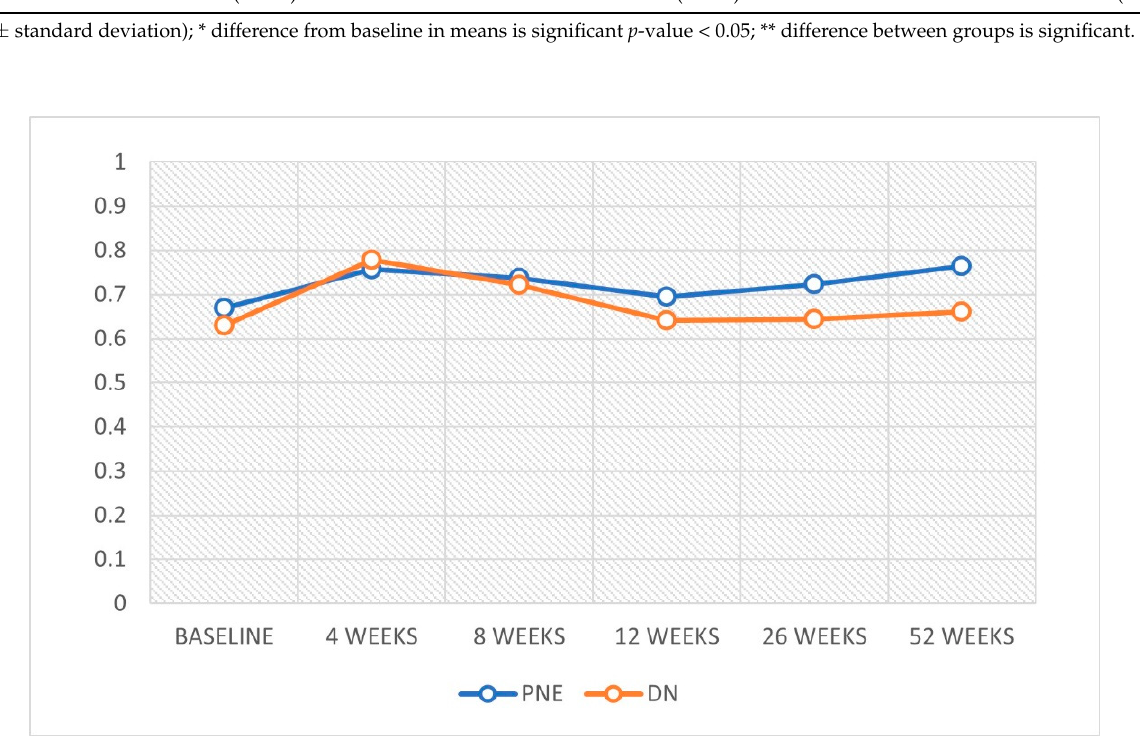
Figure 1. Variation in quality of life throughout the study.